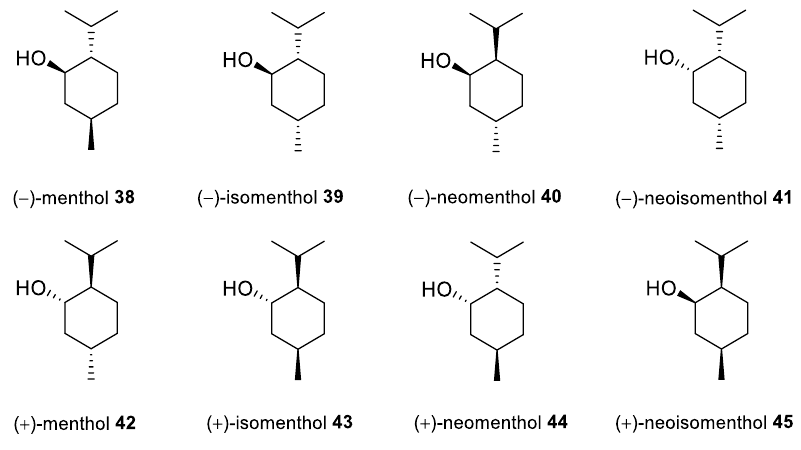
Figure 19. Isomers of